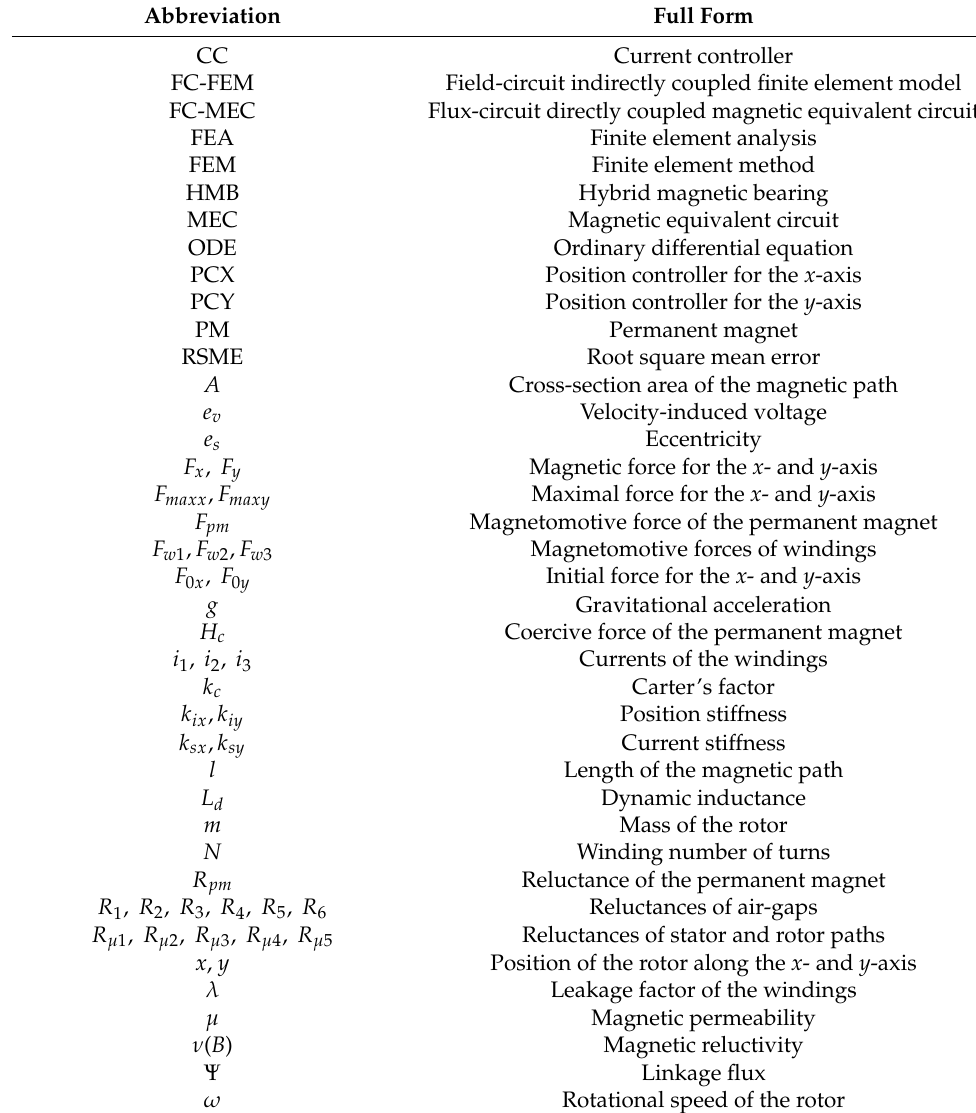
Table 1. List of acronyms used in the